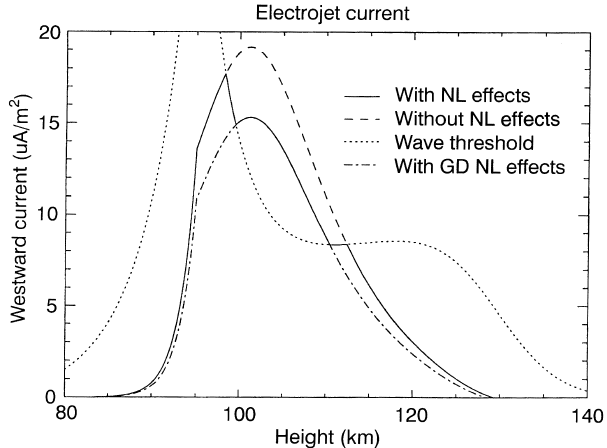
Fig. 4. Electrojet current density as a function of height. The dashed line shows the current without nonlinear effects, the solid line shows the current including effects of a two-stream wave-driven nonlinear current, the dash-dotted line shows the current including effects of a gradient-drift (GD) wave-driven current and the dotted line shows the minimum current necessary for initiating two-stream waves and the resulting